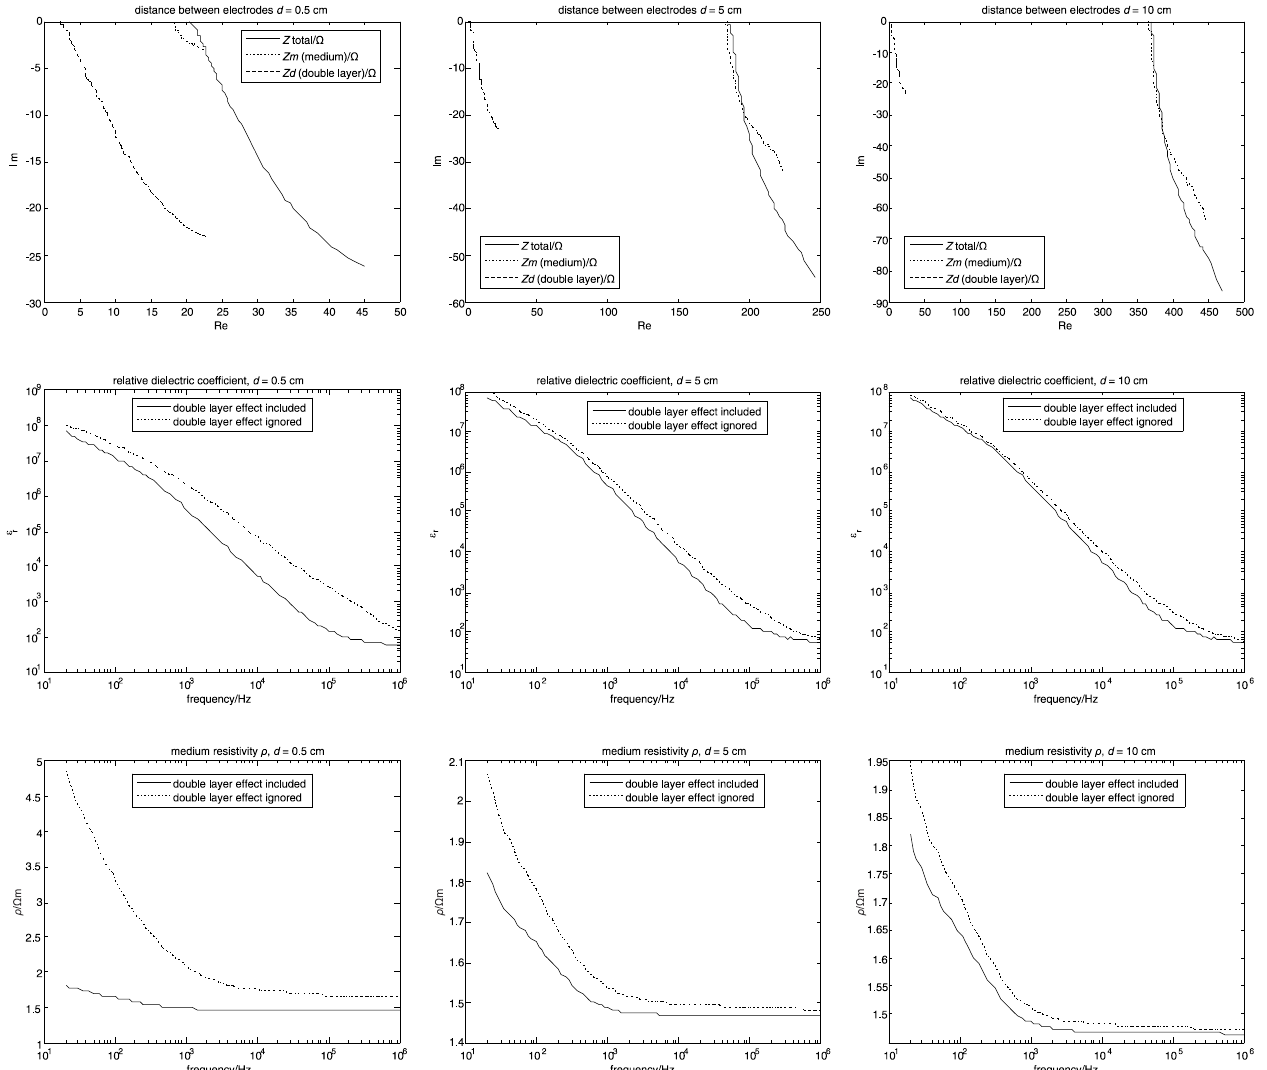
Fig. 11: Comparison of the impedance due to the suspension and the double layer. The columns from left to right present results for distance between the electrodes 0.5 cm, 5 cm and 10 cm, respectively. Rows from top to bottom represent graphs of (total and separated to double layer and suspension) absolute values of impedance, permittivity and specific resistivity, respectively.